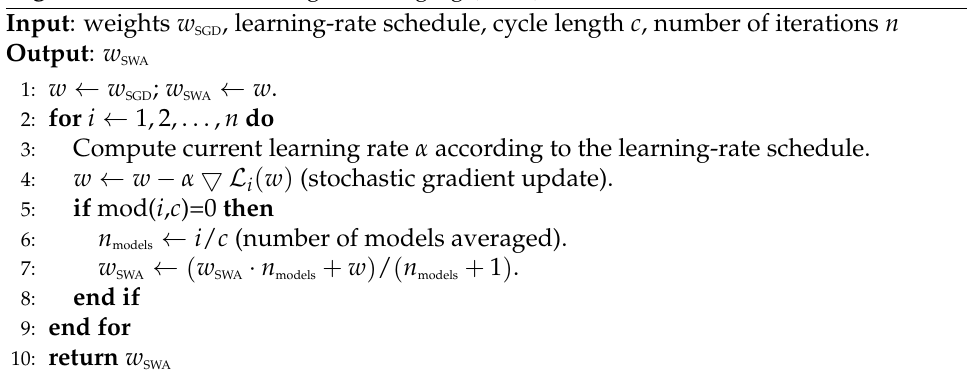
Algorithm 1 Stochastic Weight Averaging